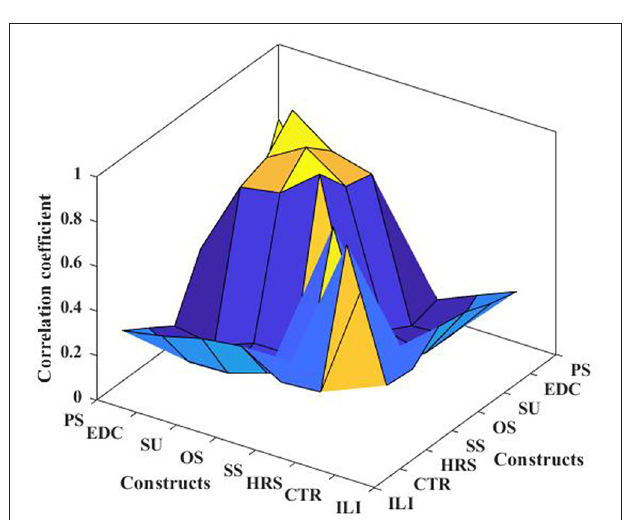
FIGURE 3 | Correlation coefficient